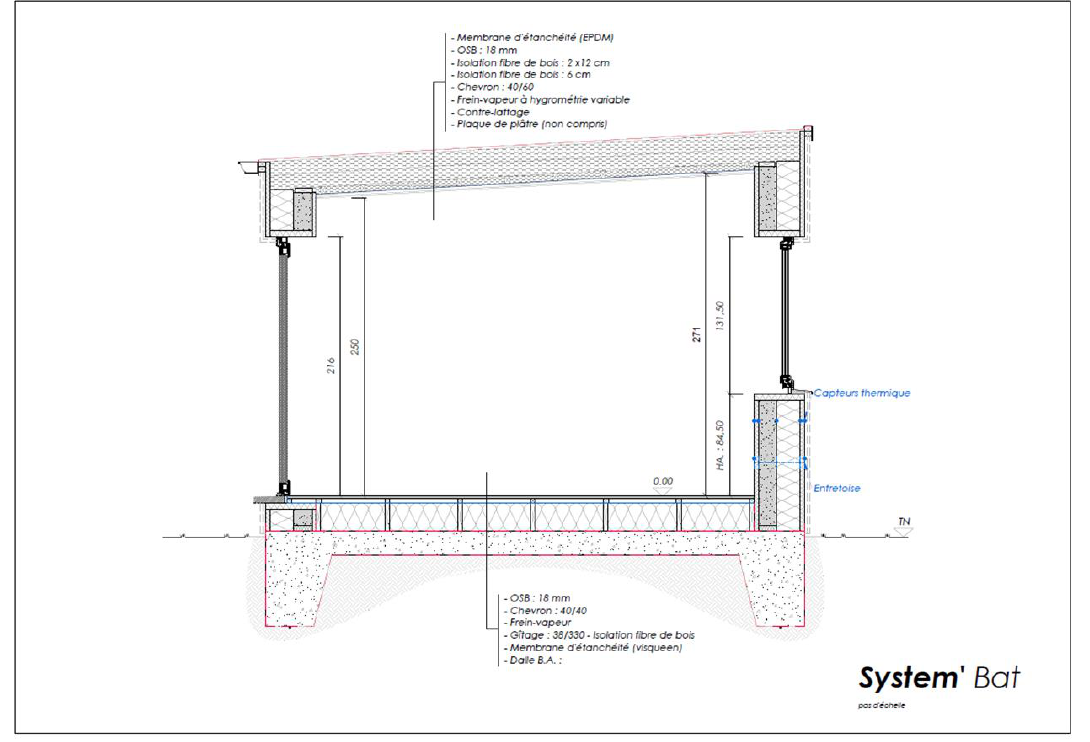
Energies 2021 , 14 , x FOR PEER REVIEW Figure A1. Vertical cut plan of the mono-zone building. Figure A1. Vertical cut plan of the mono-zone building.